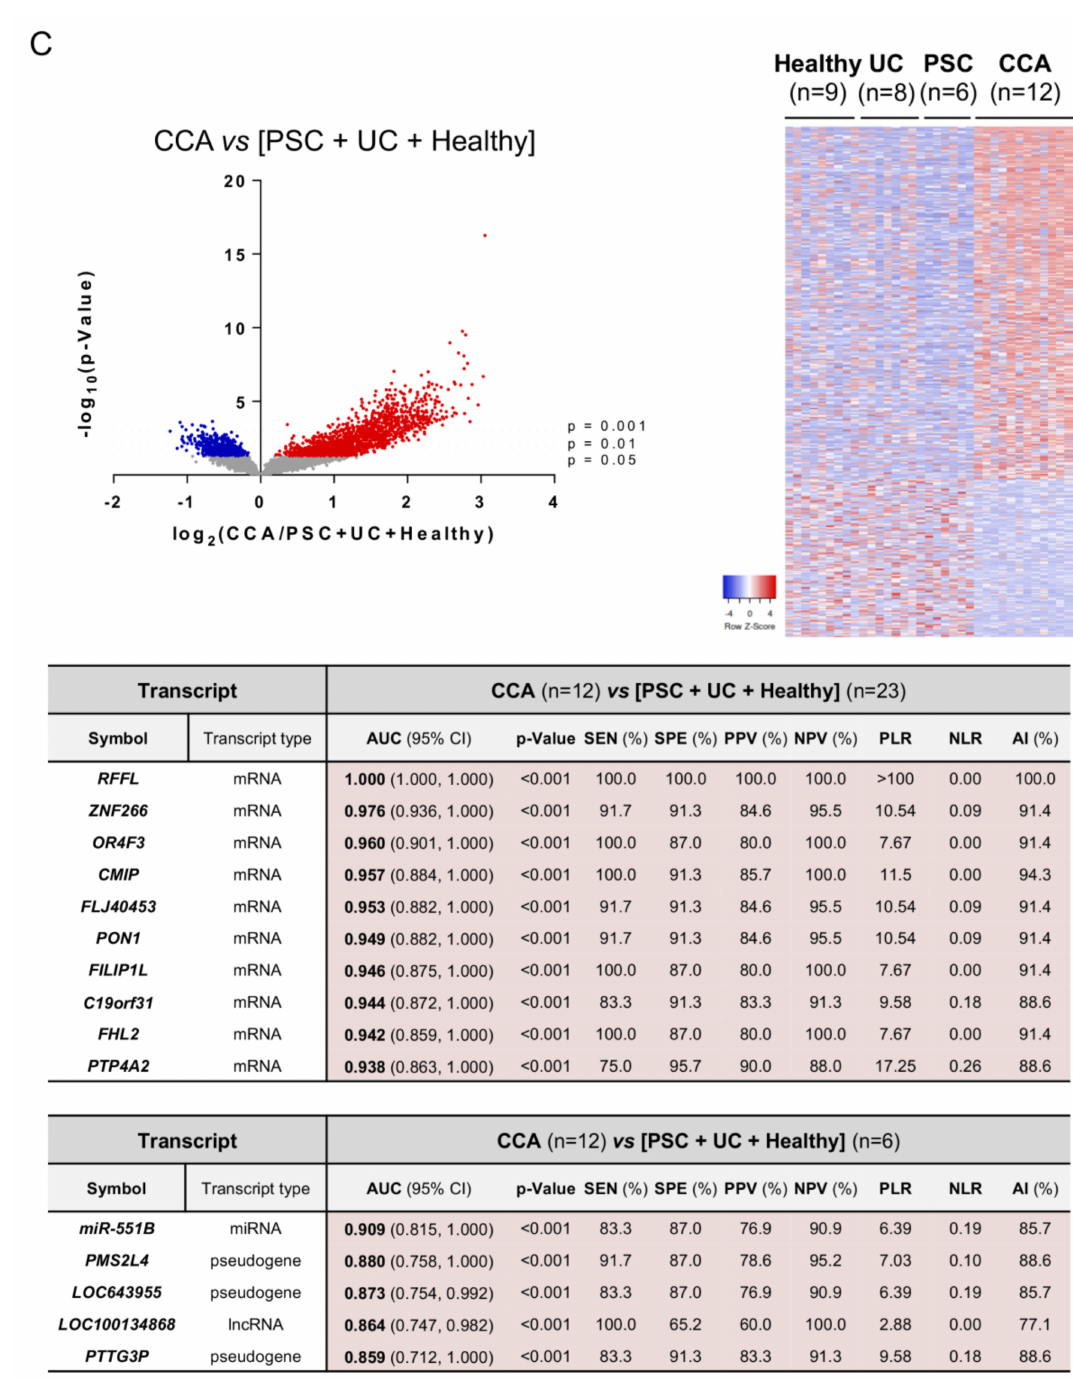
Figure 3. Differential transcriptomic profile of serum EVs and diagnostic capacity. Volcano plot ( − log 10 ( p -value) and log 2 (fold-change); up left), heatmap of the differentially expressed transcripts (up right) and diagrams with the diagnostic capacity with the highest AUC values of the 10 selected mRNAs and 5 selected non-coding RNAs in serum EVs from ( A ) CCA vs. Healthy individuals; ( B ) CCA vs. PSC; ( C ) CCA vs. (PSC + UC + Healthy individuals). Abbreviations: AI, accuracy index; AUC, area under the receiver operating characteristic curve; CI, confidence interval; lncRNA, long non-coding RNA; miRNA, microRNA; NLR, negative likelihood ratio; NPV, negative predictive value; PLR, positive likelihood ratio; PPV, positive predictive value; SEN, sensitivity; snoRNA, small nucleolar RNA; SPE,